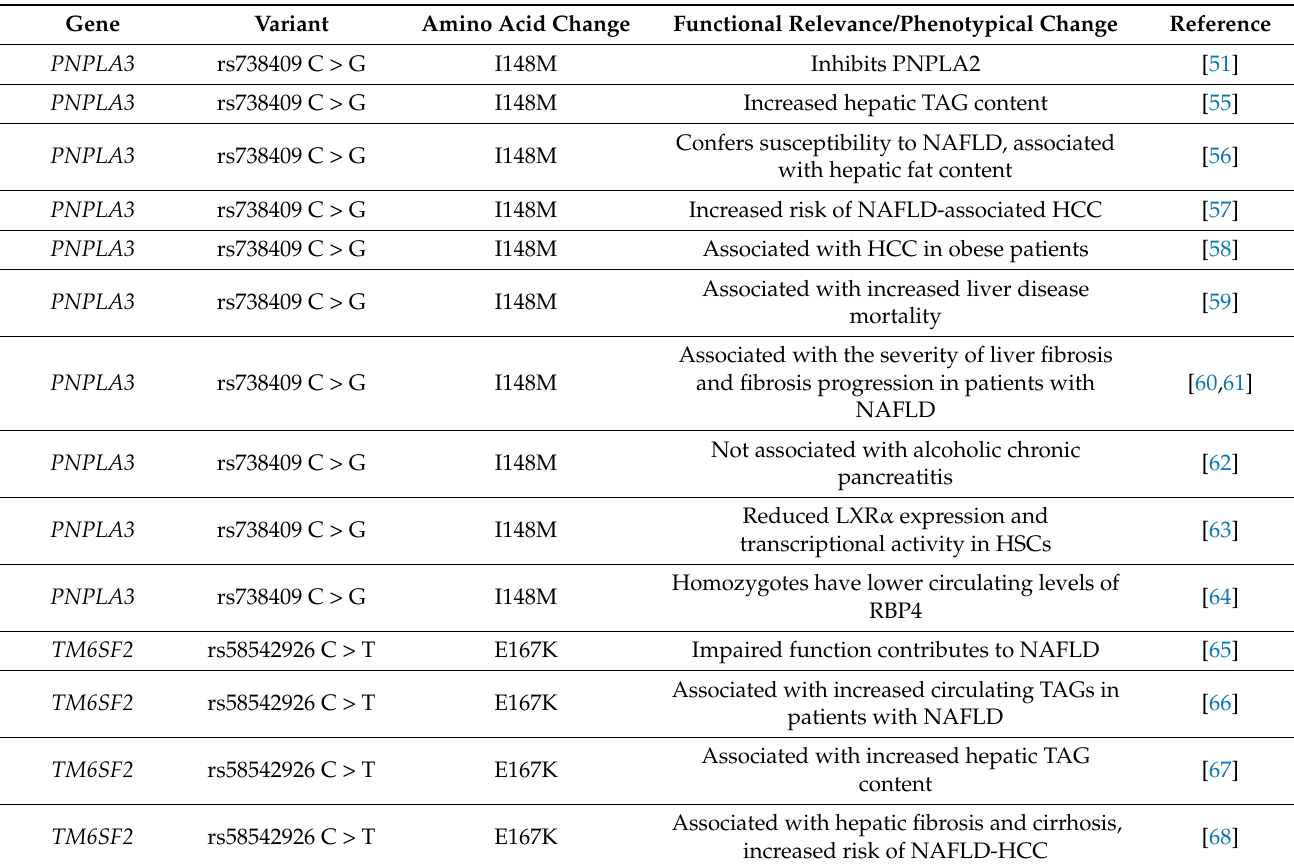
(Table 1) [51]. Mechanistically, PNPLA3 I148M sequesters ABHD5 that limits access to PN- PLA2 and attenuates PNPLA2-mediated lipolysis (Figure 2). Furthermore, PNPLA3 I148M can accumulate on LDs by evading ubiquitylation-mediated degradation (Figure 2) [52]. Consistently, Pnpla3 I148M/I148M knock-in mice accumulate PNPLA3 on LDs and develop hepatic steatosis [53]. Hepatocyte-specific overexpression of PNPLA3 I148M variant accel- erates steatohepatitis and led to liver fibrosis in a diet-induced animal model of NAFLD that sequentially developed a fatty liver, steatohepatitis, and progression of fibrosis on a high-fat diet (HFD) with the provision of sugars in the drinking water (named DIAMOND mouse model) [54]. Human carriers of PNPLA3 rs738409 show increased hepatic TAG content (Table 1) [55]. PNPLA3 rs738409 genetic variation confers susceptibility to NAFLD, associated with hepatic fat content (Table 1) [56]. Carriage of the PNPLA3 rs738409 C > G variant is associated with an increased risk of NAFLD-associated HCC (Table 1) [57]. The rs738409 genetic variant is associated with HCC in obese patients (Table 1) [58]. In the U.S. population without viral hepatitis, PNPLA3 I148M and higher NAFLD liver fat (metabolic syndrome, type 2 diabetes, fasting serum insulin, ALT, and AST were used as criteria) and fibrosis scores (age, BMI, impaired fasting glucose, diabetes, platelet count, and albumin were used as criteria) are associated with increased liver disease mortality (Table 1) [59]. The PNPLA3 rs738409 C > G variant is associated with the severity of liver fibrosis and fibrosis progression in patients with NAFLD (Table 1) [60,61]. The PNPLA3 rs738409 C > G variant is not associated with alcoholic chronic pancreatitis (Table 1) [62]. Yet, it has not been clarified whether PNPLA3 rs738409 genetic variation is associated with the incidence or prognosis of pancreatic cancer patients. Table 1. Genetic variations of PNPLA3 , TM6SF2 , and HSD17B13 and phenotypical